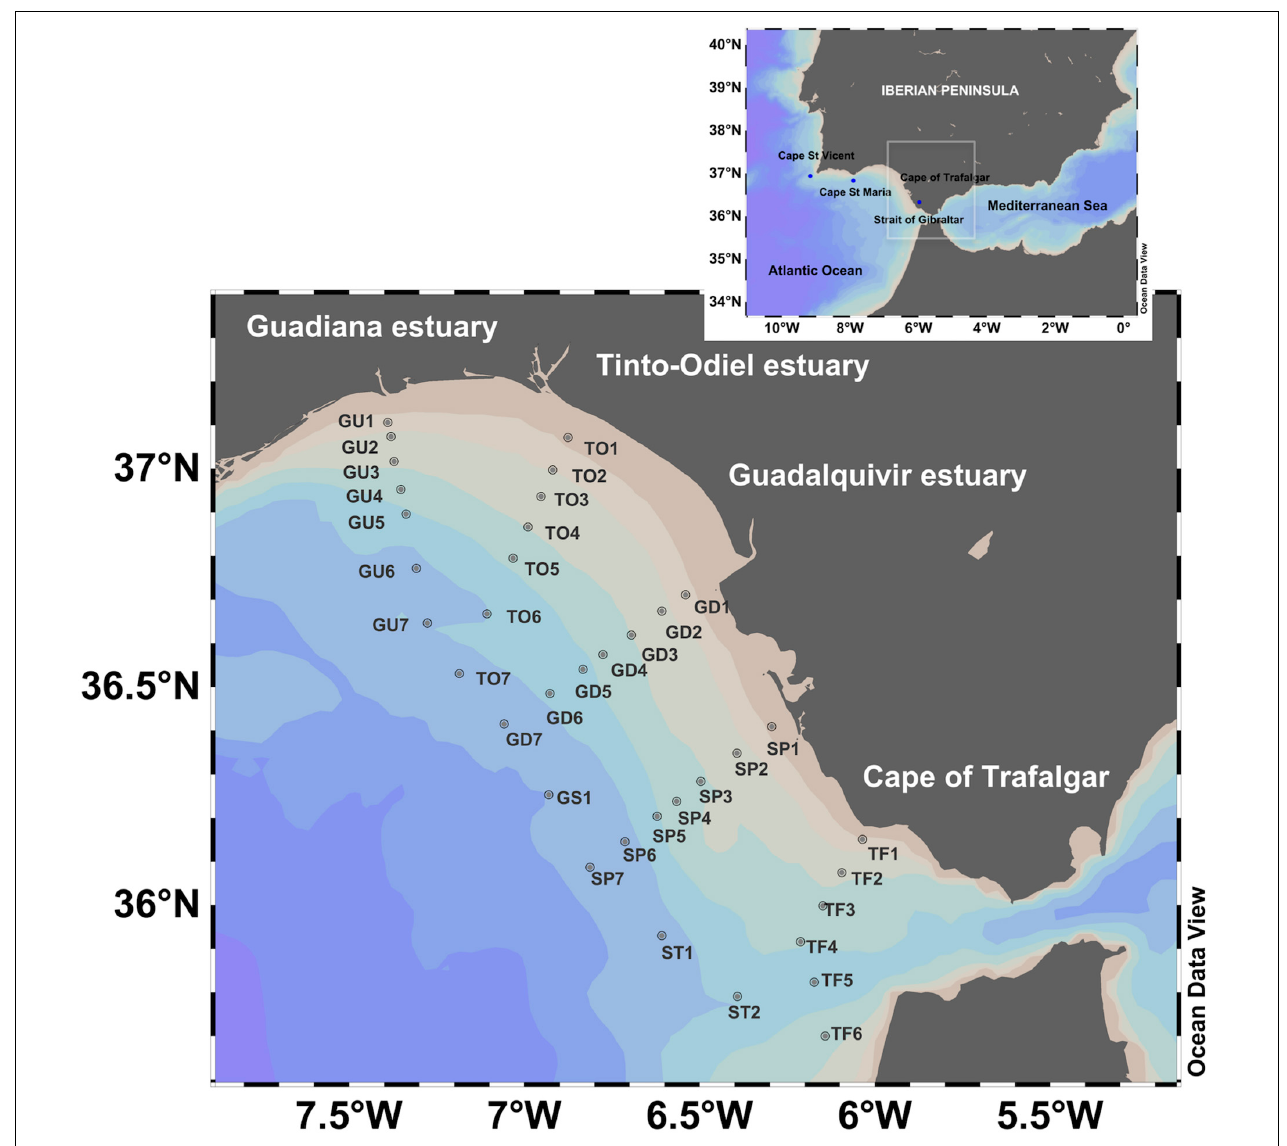
FIGURE 1 | Sampling stations in the Gulf of Cádiz: Guadiana (GU), Tinto-Odiel (TO), Guadalquivir (GD), Sancti Petri (SP), Trafalgar (TF) and external stations (GS1, ST1, and